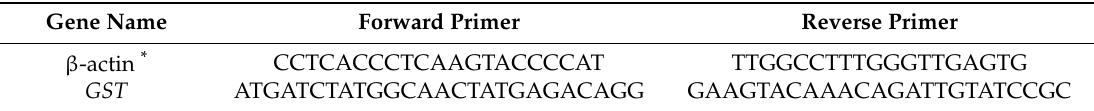
Table 1. Primer sequences used for